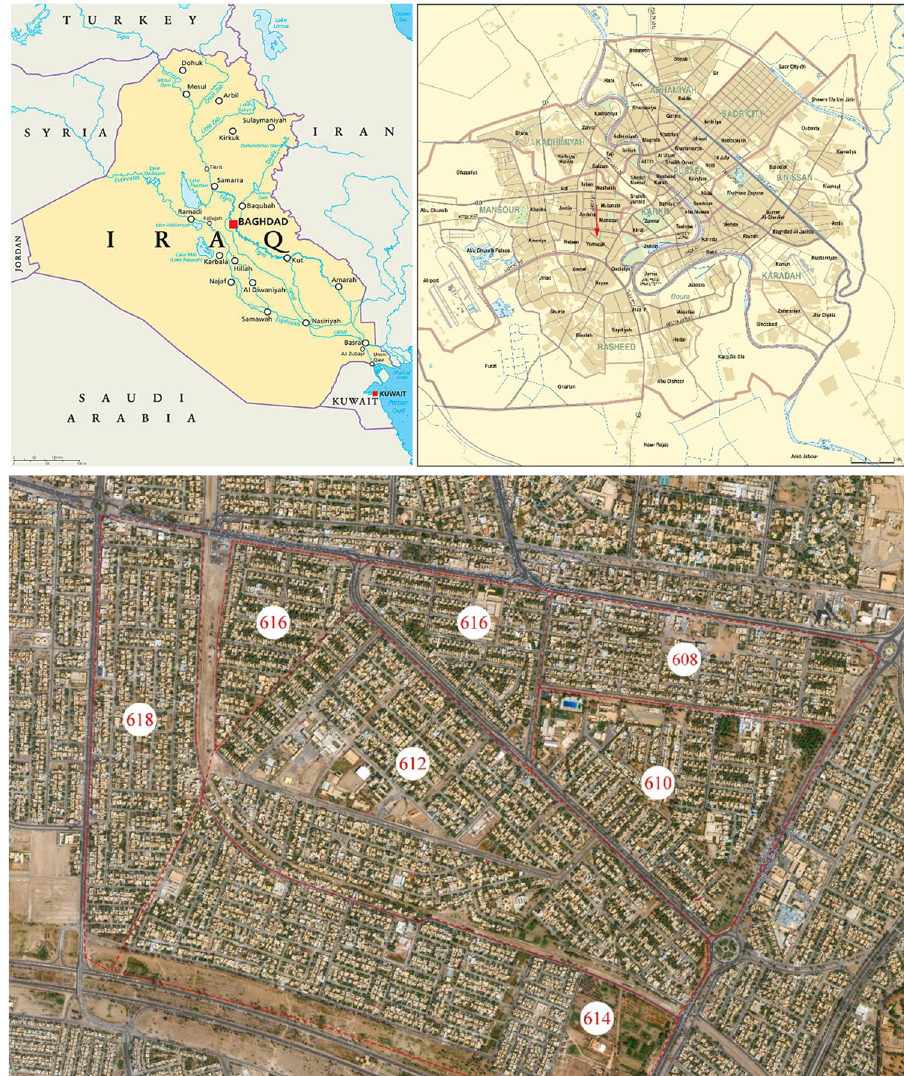
Figure 1: The AL - Yarmouk studied